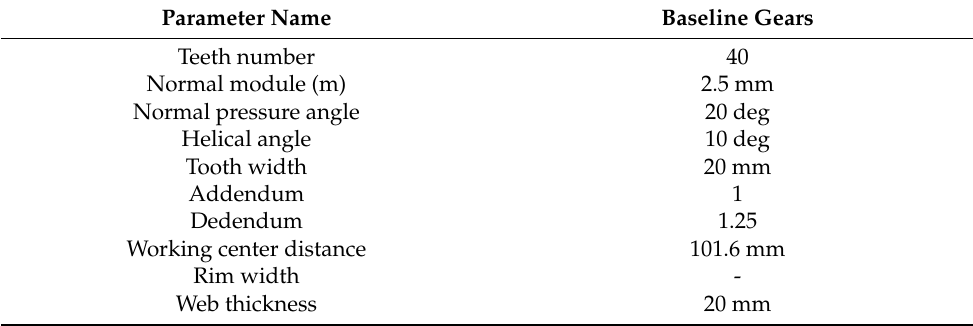
Table 1. Gears design